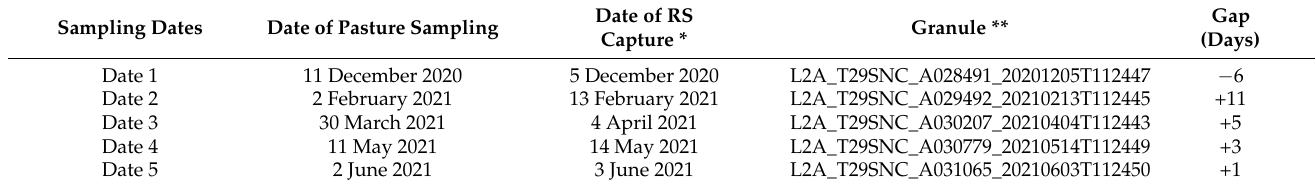
Table 1. Dates of pasture sampling and Sentinel-2 imagery capture (remote sensing,